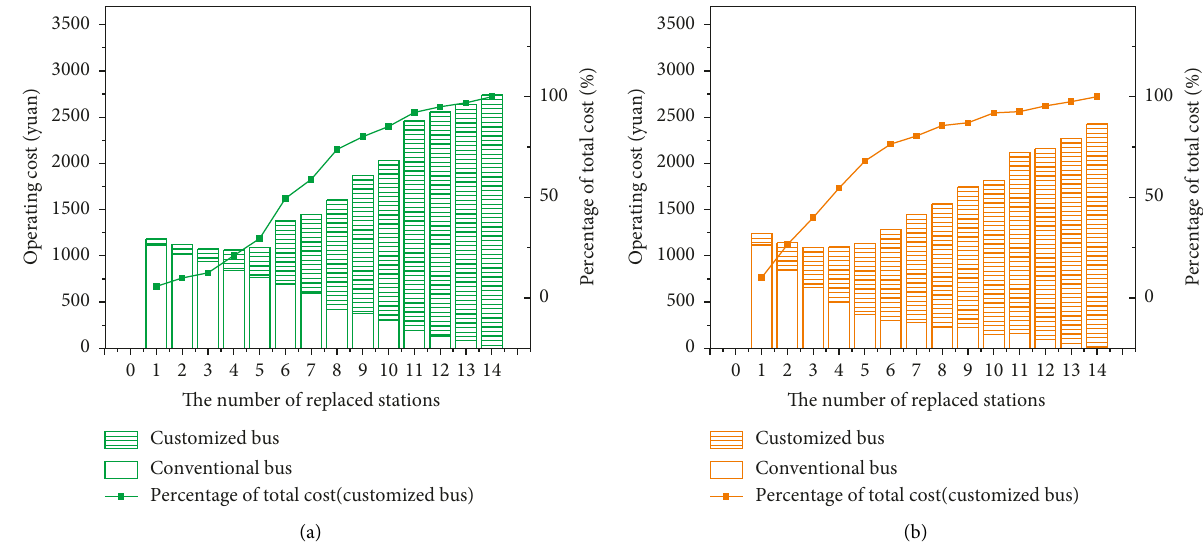
Figure 6: The compositions of operating costs in (a) integrated operation mode I and (b) integrated operation mode